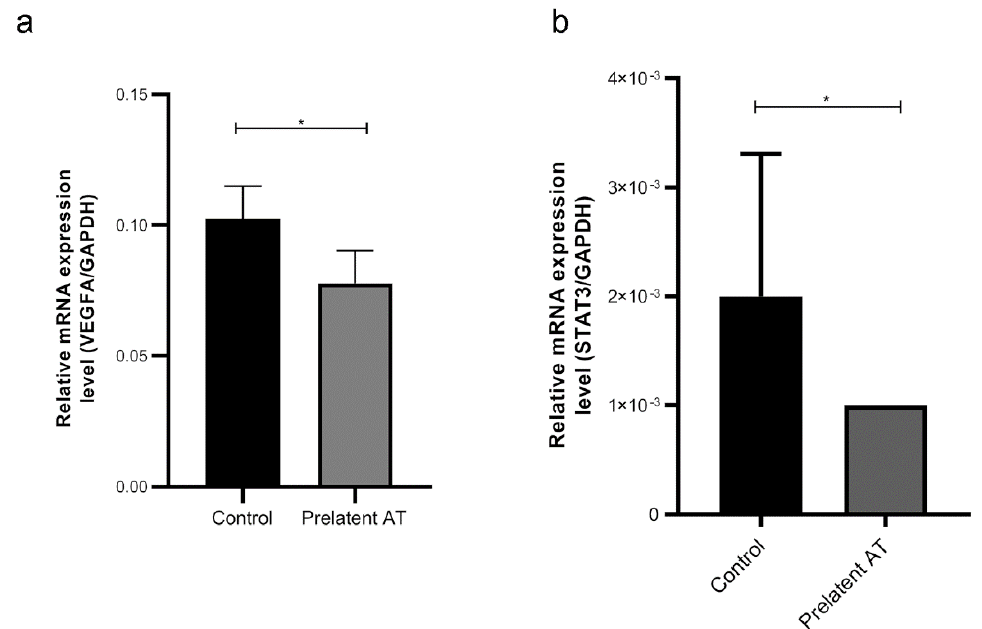
Figure 6. Relative expression of VEGFA ( a ), and STAT3 ( b ) to GAPDH mRNA (2- ∆ Ct). Each condition was evaluated in triplicate, and 5 different samples per group were analyzed. * p < 0.05.